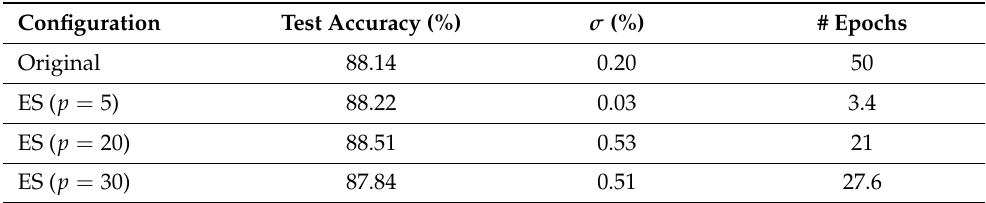
Table 2. Results on MedMNIST2D OrganSMNIST dataset in a maximum of 50 epochs. σ is the standard deviation and each result is the mean of five trials.